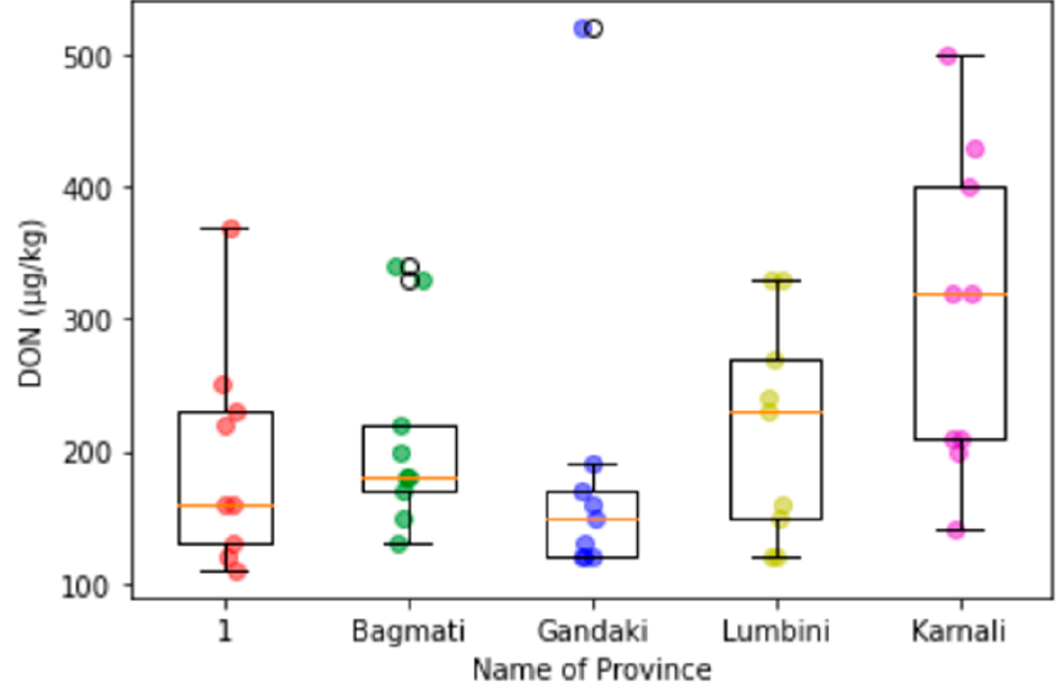
Figure A7. Contamination level of DON.